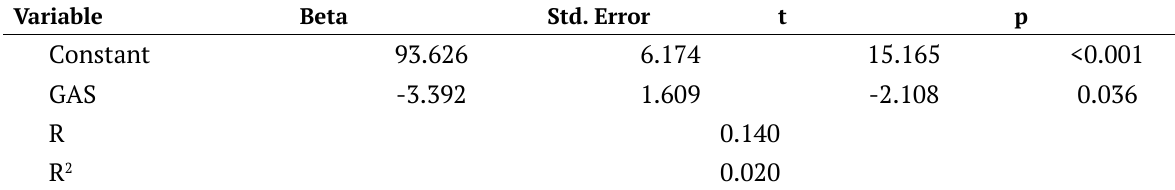
Table 6. Simple Linear Regression Analysis (Model